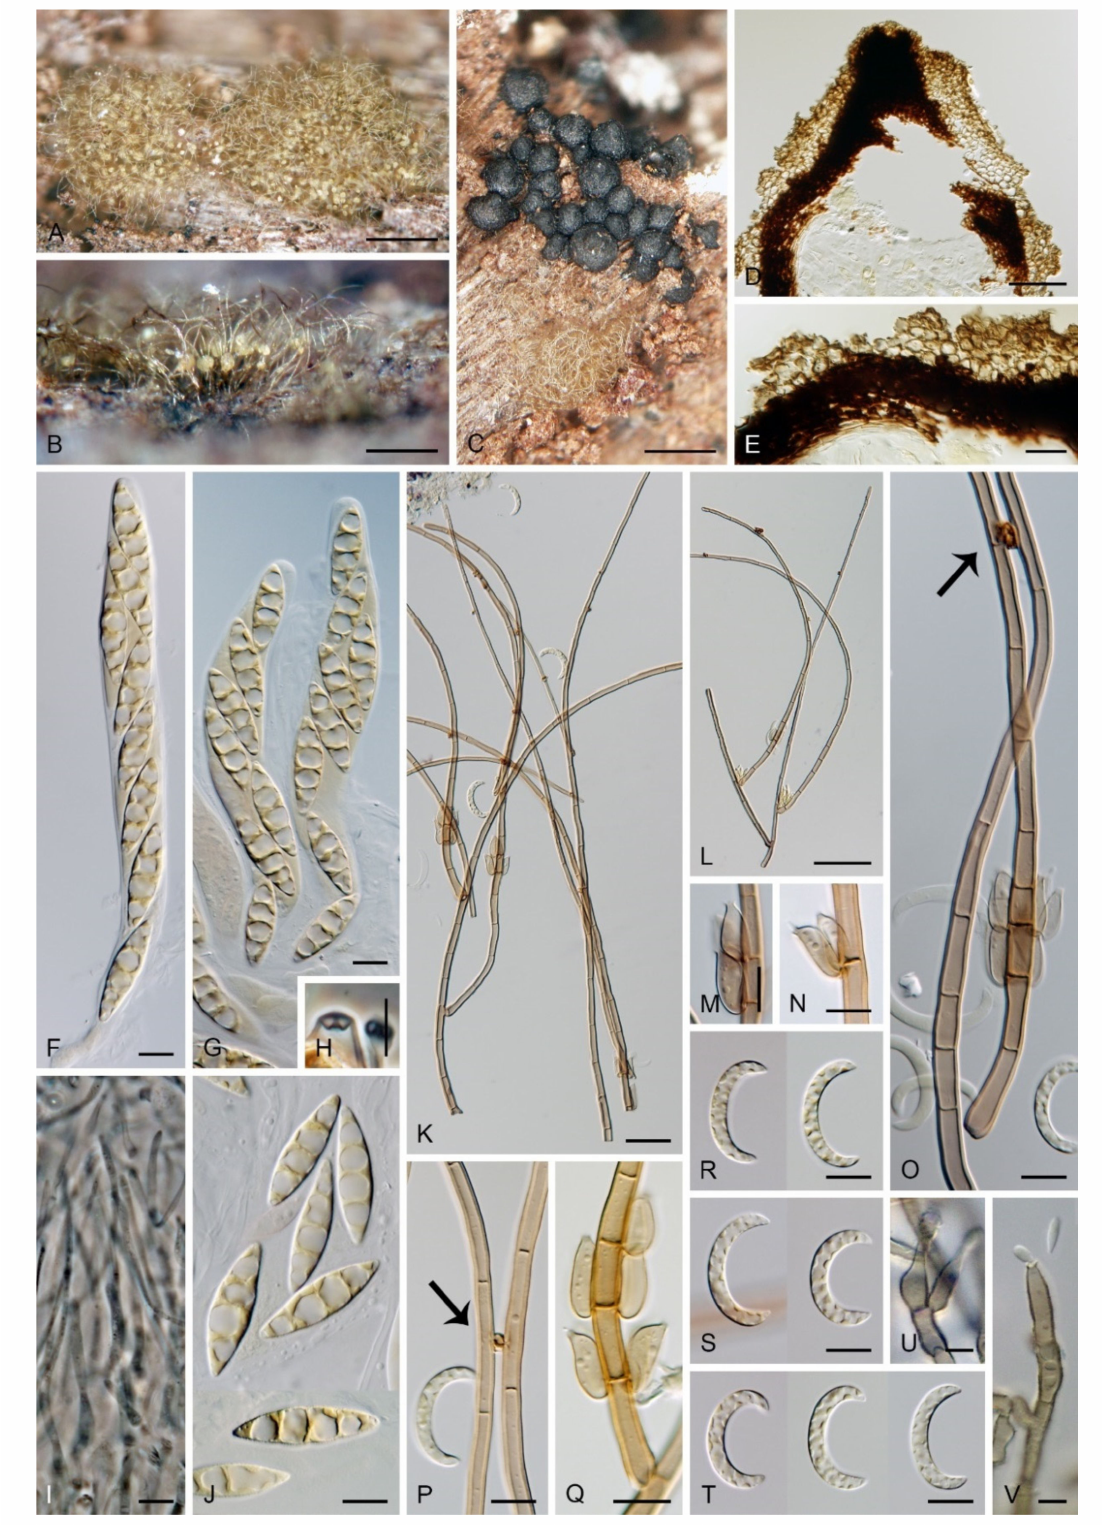
Figure 10. Zanclospora aurea (ICMP 23703 ex-type). ( A , B ) Colonies. ( C ) Ascomata associated with Zanclospora anamorph. ( D , E ) Vertical sections of the ascomal wall. ( F , G ) Asci. ( H ) Ascal apices with an apical annulus. ( I ) Paraphyses. ( J ) Ascospores. ( K , L , U , V ) Conidiophores. ( M – Q ) Conidiophores with phialides, in detail (arrow indicates connectives through with the conidiophores anastomose). ( R – T ) Macroconidia. Images: ( A – T ) on the natural substrate; ( U , V ) on PCA after 4 months. Bars: ( A – C ) = 500 µ m; ( D , L ) = 50 µ m; ( E ) = 20 µ m; ( F – K , M – T ) = 10 µ m; ( U , V ) = 5 µ